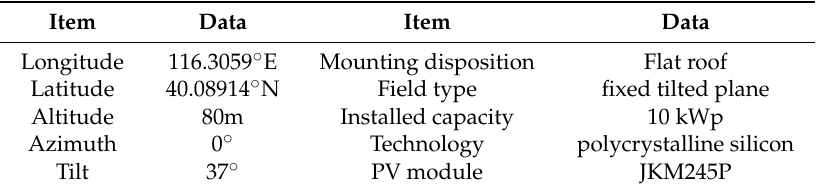
Table 1. PV power plant